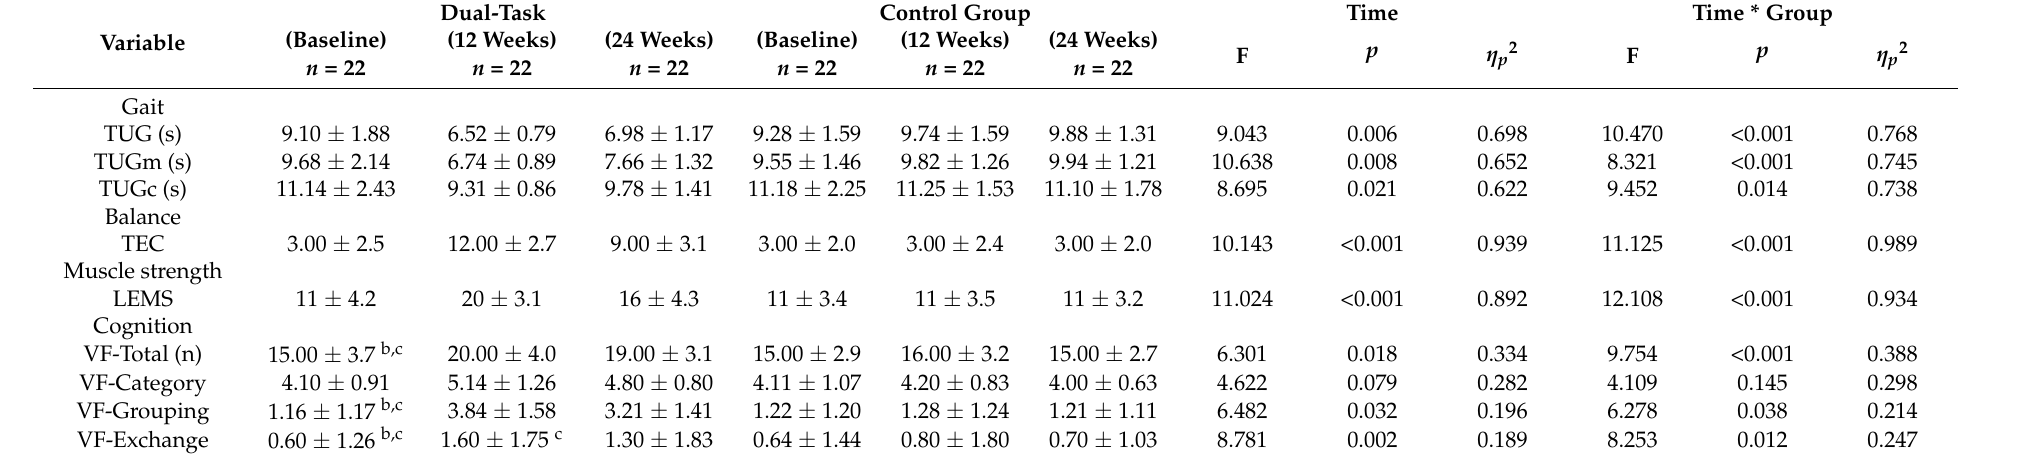
Table 4. Results between the dual-task and control groups for gait, balance, lower extremity muscle strength, and cognitive